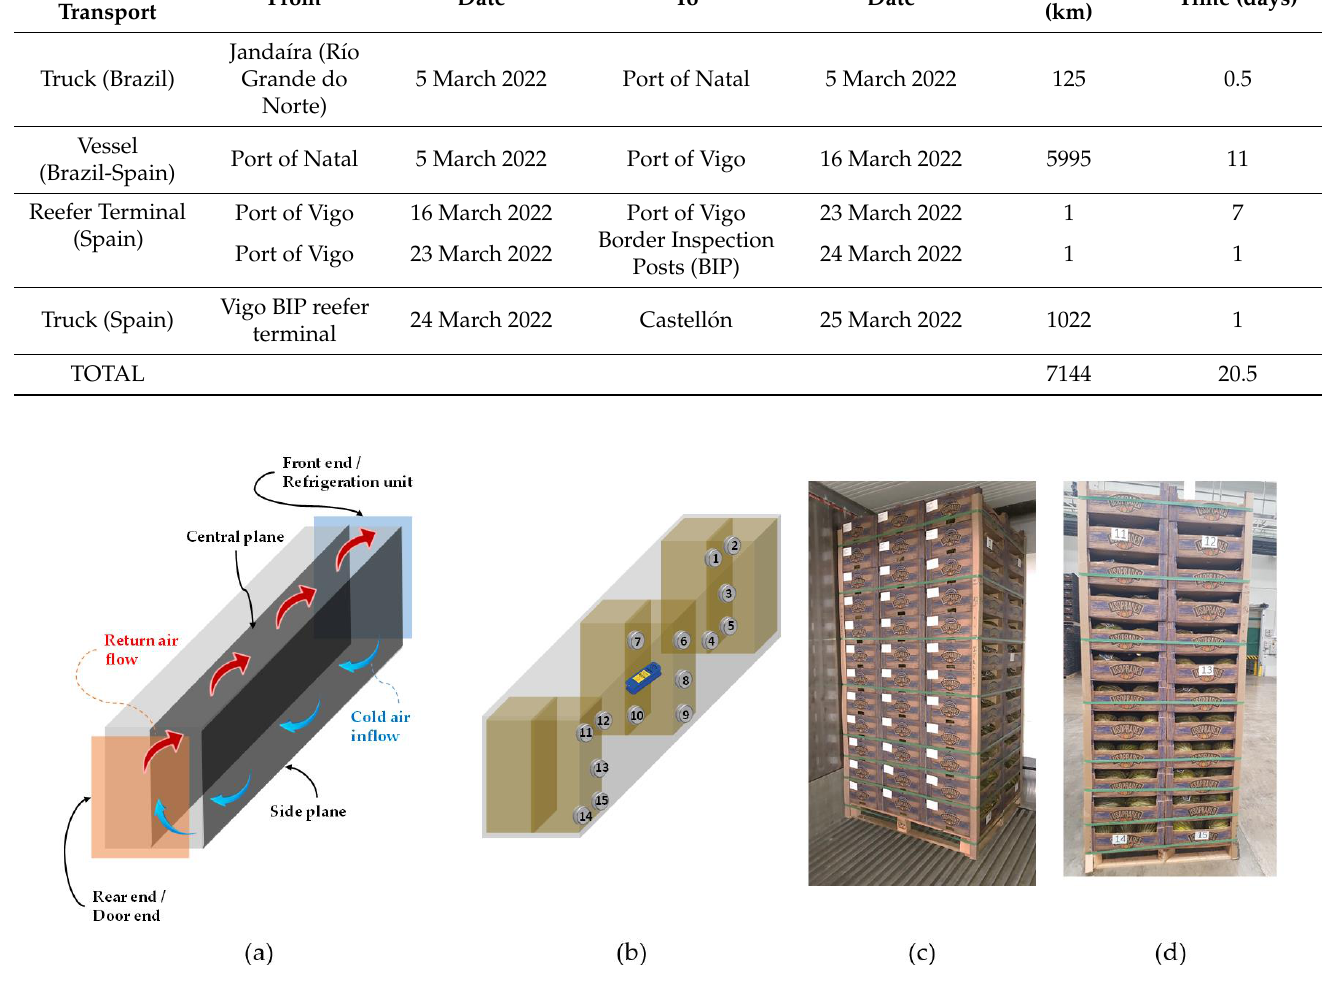
Figure 1. Diagram of the refrigerated container ( a ) and distribution of the ibutton loggers (numbered circles) and Xsense® logger (in blue) ( b ) and pallets ( c , d ) inside the container.